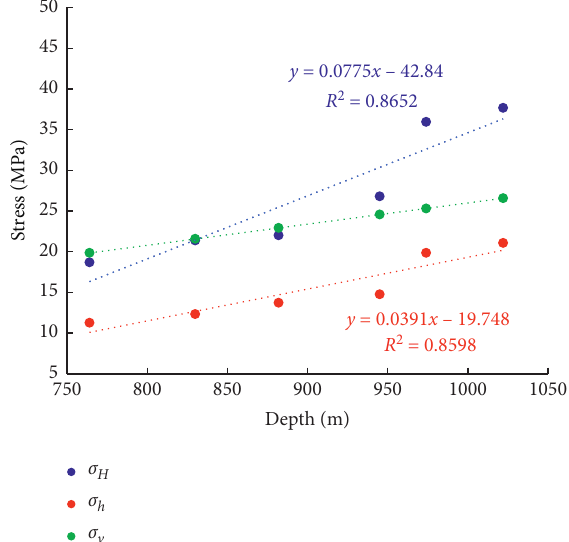
Figure 4: Variation of ZK2 measured in situ stress with